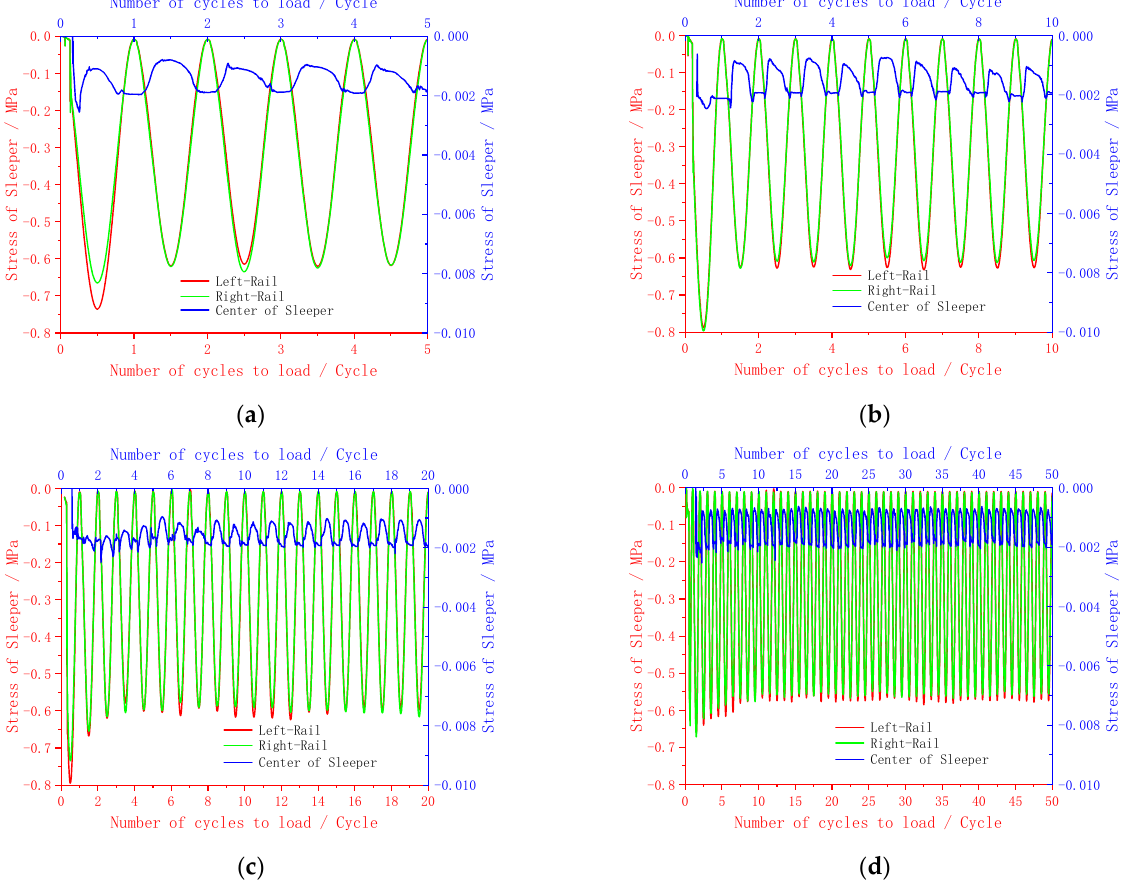
Figure 11. Distribution of stress in sleeper. ( a ) 5 Hz. ( b ) 10 Hz. ( c ) 20 Hz. ( d ) 50 Hz.